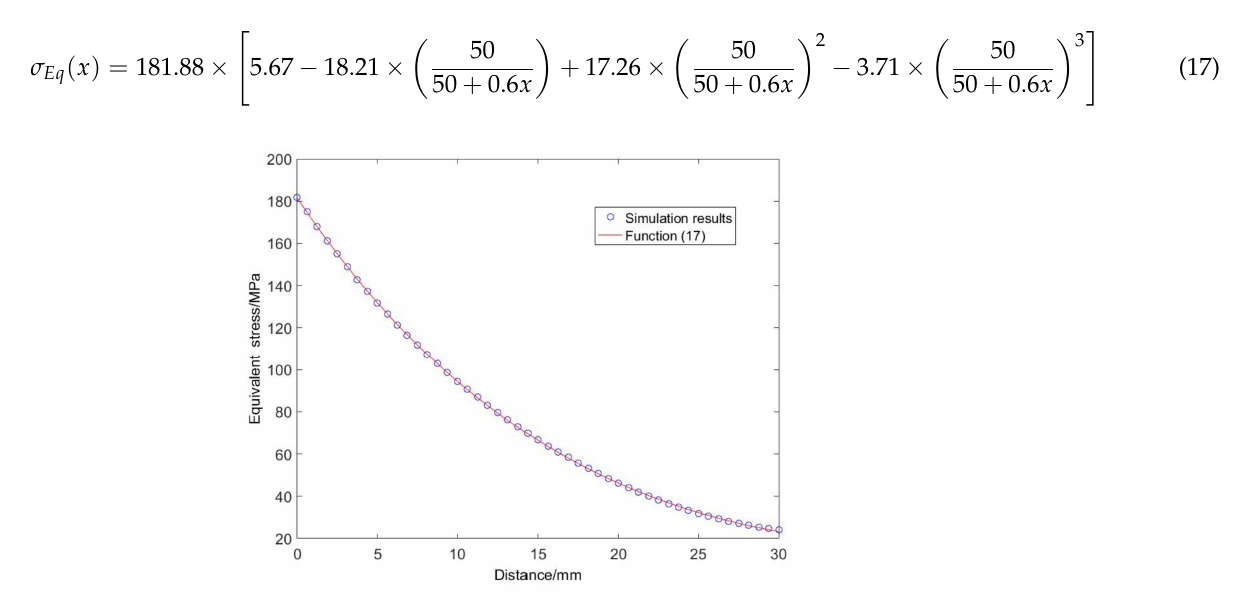
Figure 18. Stress distribution curve on focusing